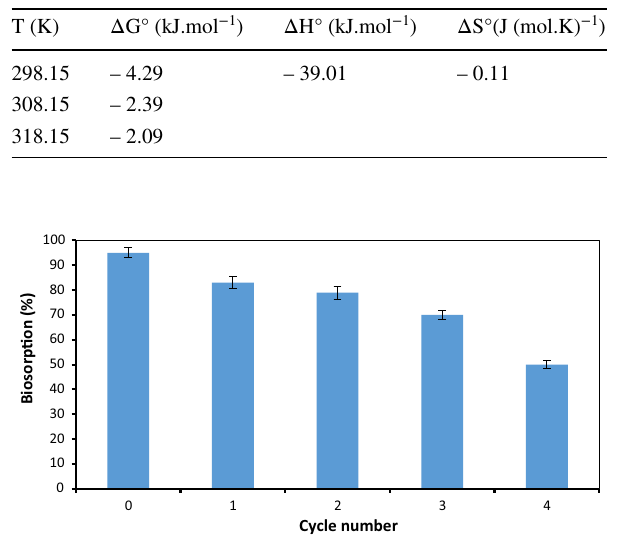
Fig. 7 Effect of reusability of the biosorbent on removal